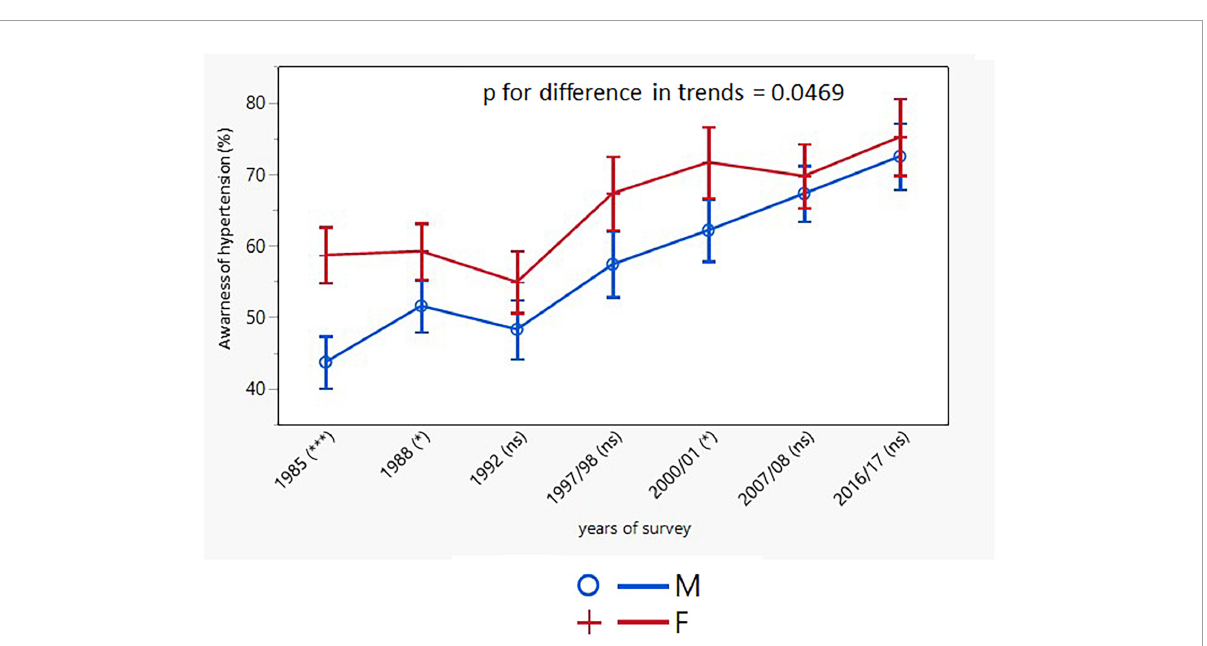
FIGURE5 Age-adjusted trends in awareness of hypertension (95% confidence interval). M, males; F, females; p for differences in trends between males and females. NS or asterisks indicates in brackets after survey years the sex differences in respective surveys after Bonferroni correction; * p < 0.05; *** p <